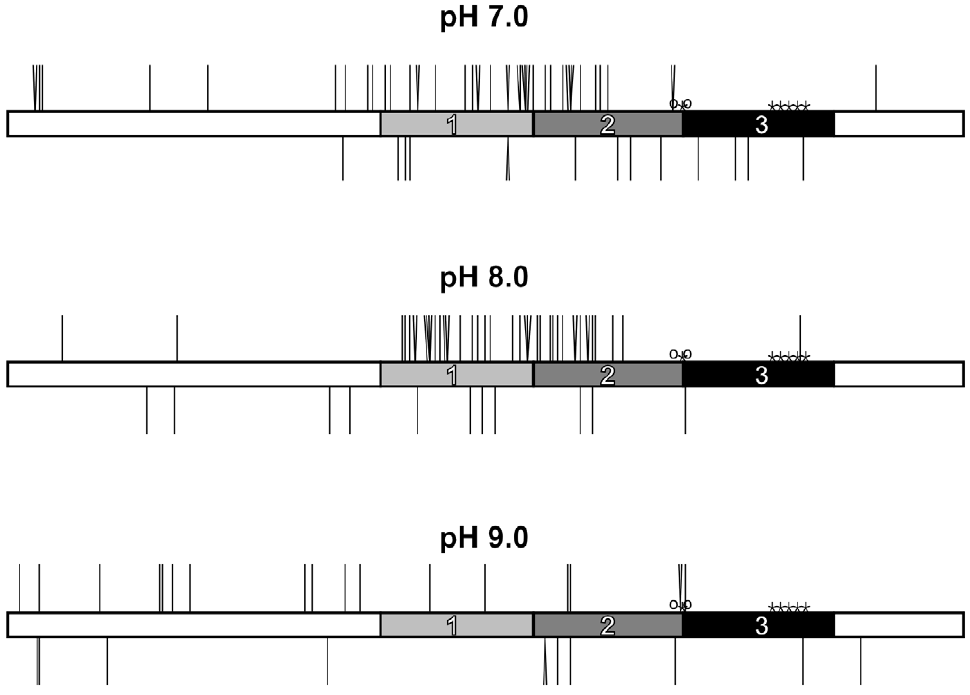
Figure 3. The location and orientation of Tn7 insertion within the GAA N TTC repeat is pH dependent. Depictions of the MluI to XbaI fragment containing the GAA N TTC repeat with vertical lines indicating Tn7 insertion events at pH 7, pH 8 and pH 9 both within and near the repeat. The repeat is divided into thirds, and point deletions and substitutions in the GAA repeat are indicated by open circles and asterisks, respectively. Lines extending above represent insertions events in the ( + ) orientation, defined as the transposon oriented from left to right. Lines extending below represent insertion events in the ( 2 ) orientation with the transposon oriented right to left. Insertions performed at pH 7 and pH 8 show a strong bias for the left to right ( + ) orientation of the transposon. At pH 7.0 and pH 8.0, Tn7 shows a bias for insertion within the largely uninterrupted regions 1 and 2. In contrast, region 3, an area where the GAA N TTC repeat contains multiple interruptions, is not a favored target for insertion. Location of insertion was determined by DNA